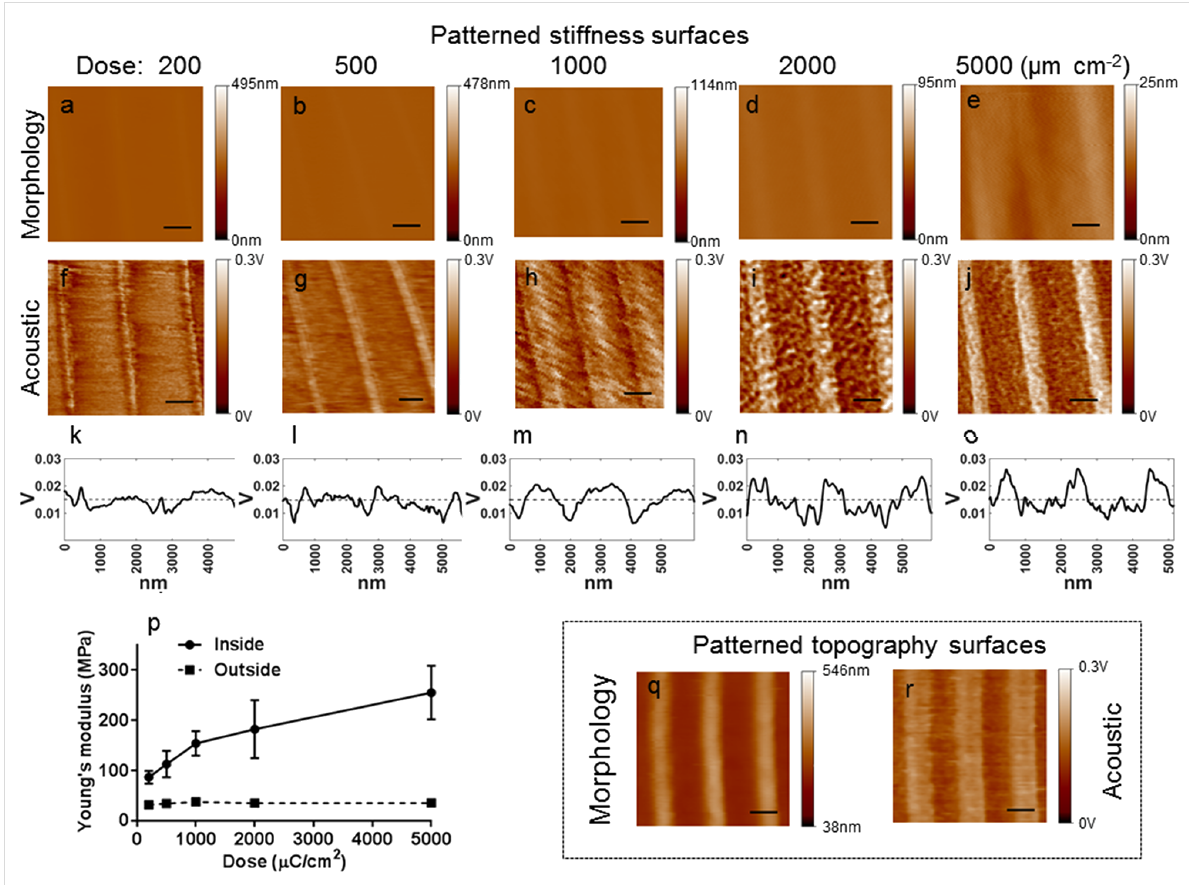
Figure 2: AFAM characterization of the SU-8 film surfaces. Morphological images (a–e) and acoustic images (h–j) of the exposed and undeveloped SU-8 film surfaces (patterned stiffness surfaces) exposed to EBL at exposure doses of 200, 500, 1000, 2000 and 5000 μ C cm − 2 , respectively. (k–o) Vibrational amplitudes in cross sections of the acoustic images (p) Young's modulus values of the undeveloped SU-8 arrays at different expo- sure doses.; “inside” designates the bright regions (solid line) and “outside” corresponds to the dark regions (dash line). Morphological image (q) and acoustic image (r) of the patterned topography surface at an exposure dose of 1000 μ C cm − 2 . Scale bars: 1 μ